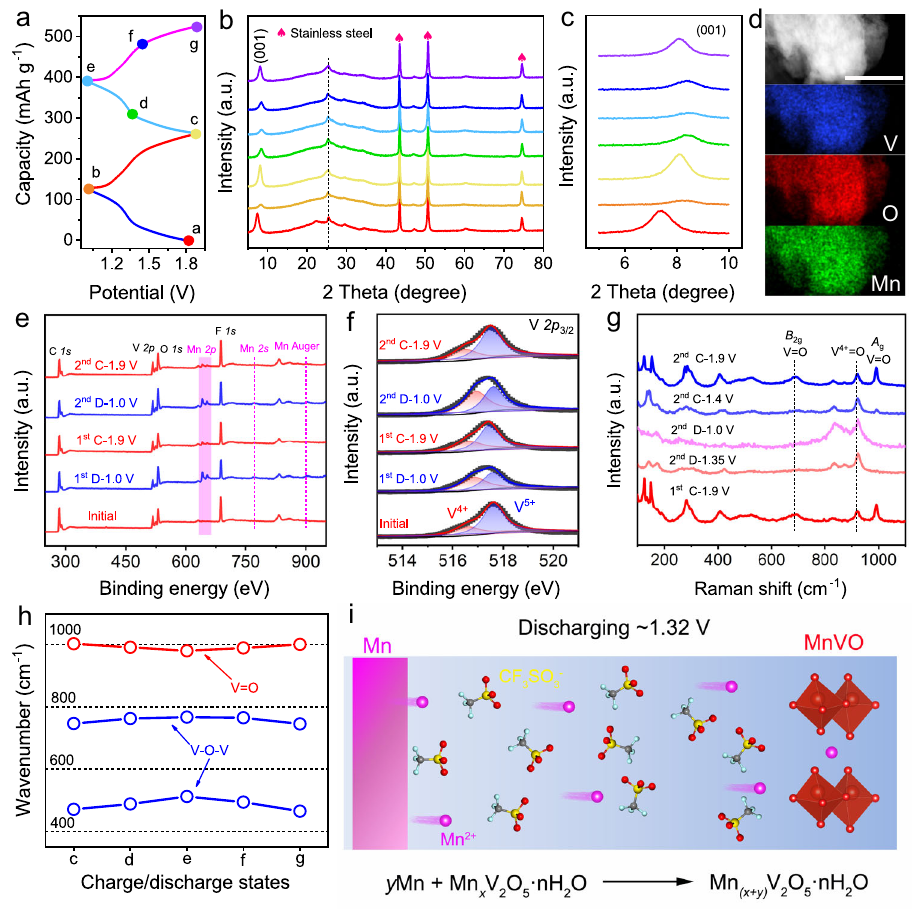
Fig. 3 Mn 2 + insertion mechanism in MnVO electrodes. a The initial two GCD curves at 0.2 A g − 1 . b XRD patterns at different charge/discharge states. c An enlarged view of the (001) re fl ection from the XRD patterns in ( b ). d TEM element mapping in fully discharged electrodes. Scale bar: 200 nm. XPS spectra of e full-spectrum and f V 2 p 3/2 at fully discharged/charged states. g Raman and h FTIR spectra at the selected charge/discharge states. i Schematic diagram of the discharging mechanism of Mn||MnVO